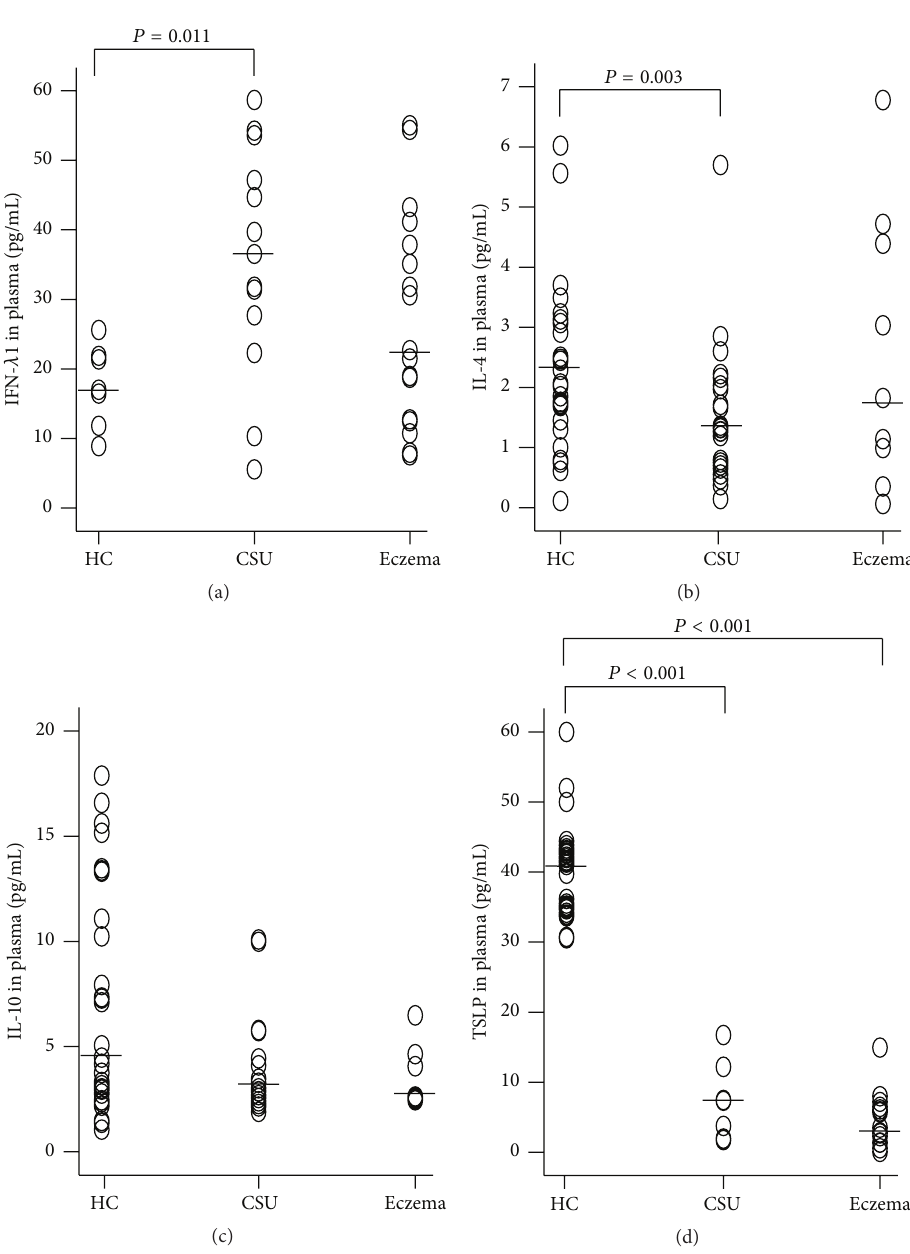
Figure 1: Scatter plots of the levels of interferon- (IFN-) 𝜆 1 (a), IL-4 (b), IL-10 (c), and thymic stromal lymphopoietin (TSLP) (d) in the plasma of the patients with urticaria and healthy control subjects (HC). Each symbol represents the value from one subject. The median value is indicated with a horizontal line. 𝑃 < 0.05 was taken as statistically significant. See Table